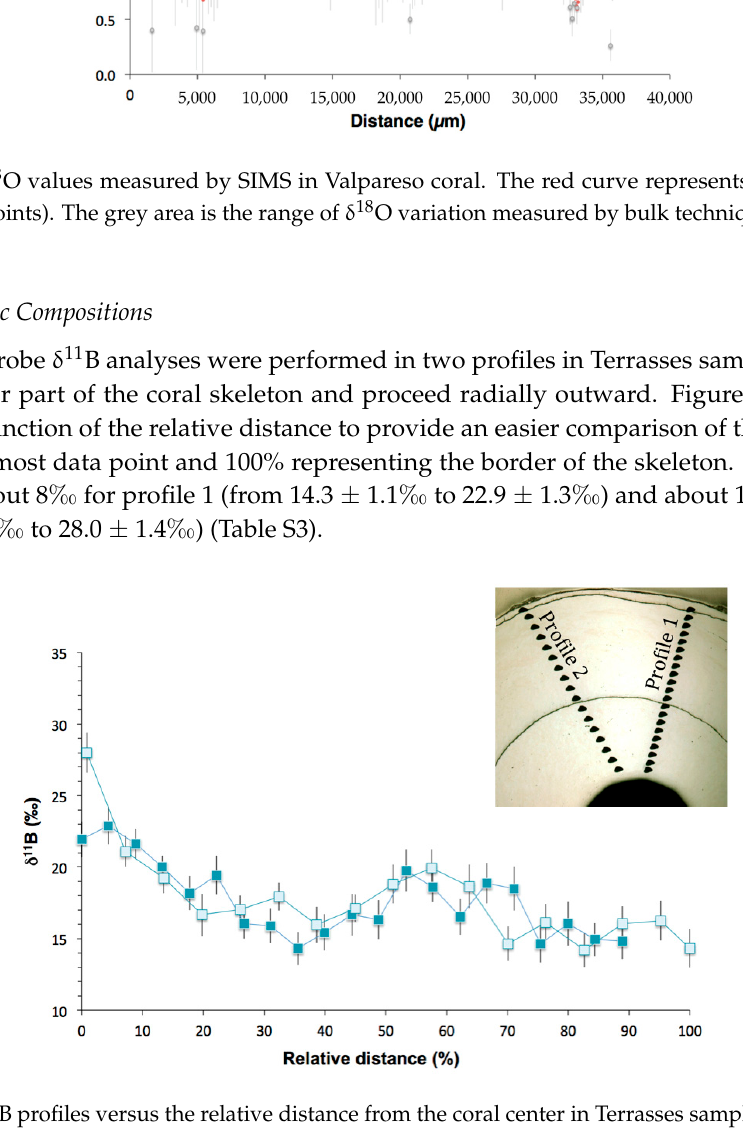
Figure 8. δ 11 B profiles versus the relative distance from the coral center in Terrasses sample. Profile 1 is represented by the dark blue squares and profile 2 by the light blue squares. Error bars are ±1 σ .